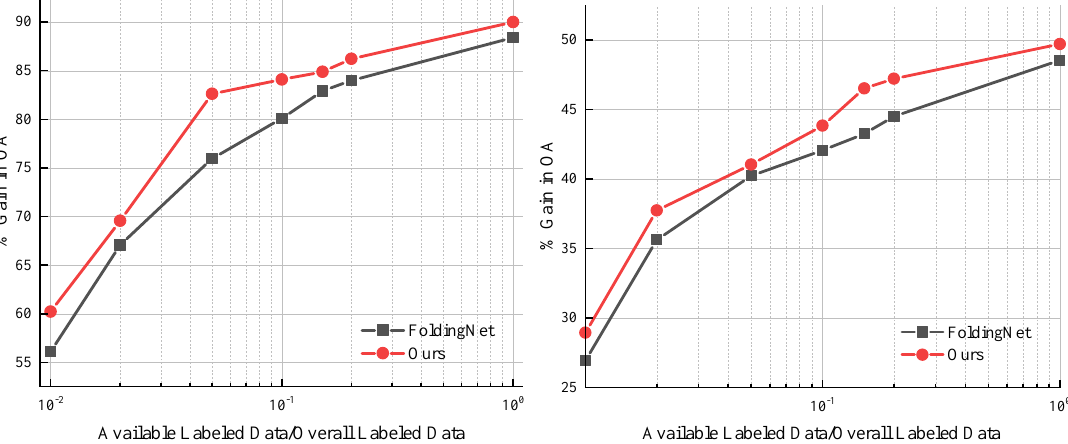
Figure 3. Test results of a linear support vector machine (SVM) classifier on ModelNet40 ( left ) and ScanObjectNN ( right ) under semi-supervised